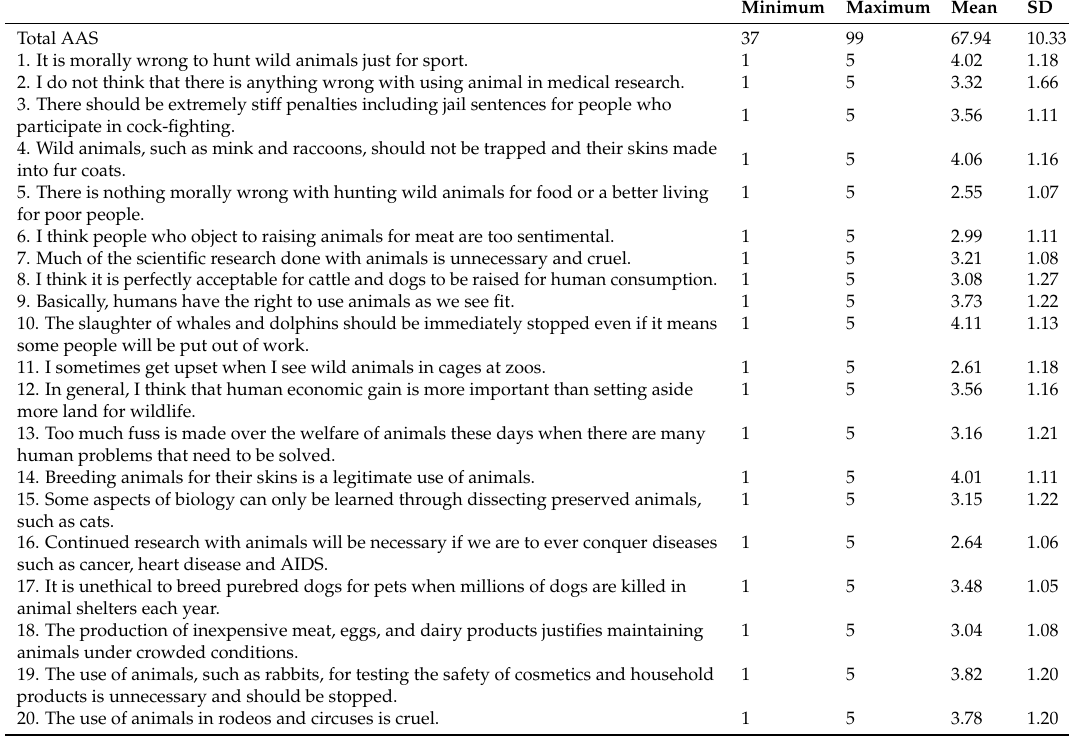
Table 3. Descriptive statistics: total Animal Attitude Scale (AAS) and individual variables mean